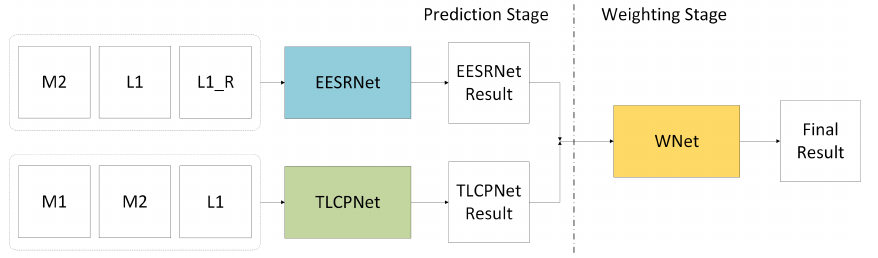
Figure 2. Flowchart of the whole network. M 1 and M 2 refer to the coarse images at the reference date t 1 and the prediction date t 2 . L 1 refers to the fine image at t 1 and L 1 _ R refers to the resample image of L 1